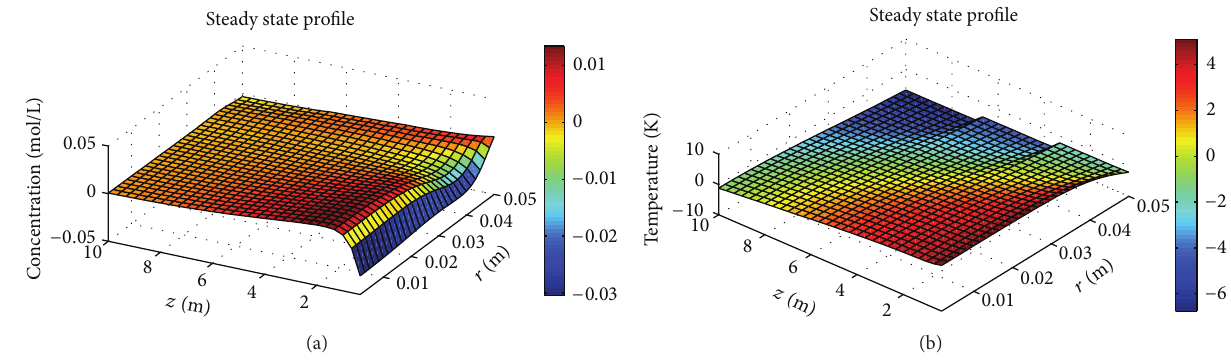
Figure 13: Steady state error (temperature and concentration) for Test 1.